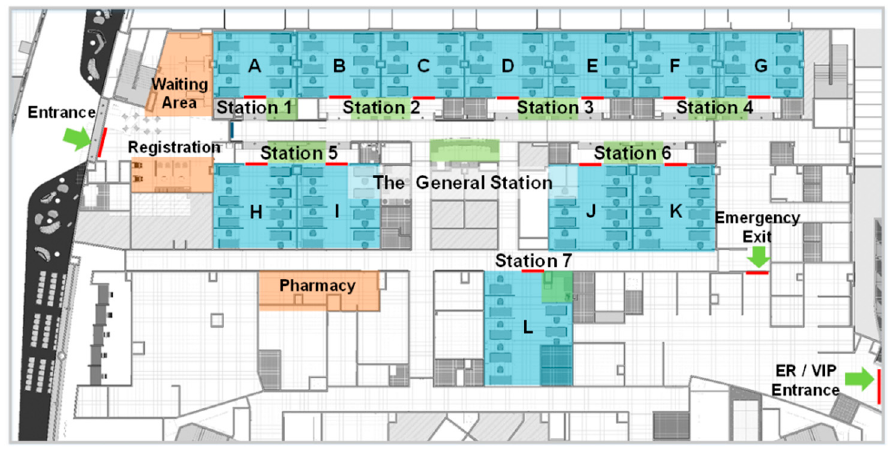
Table 1. Healthcare 2020 , 8 , x